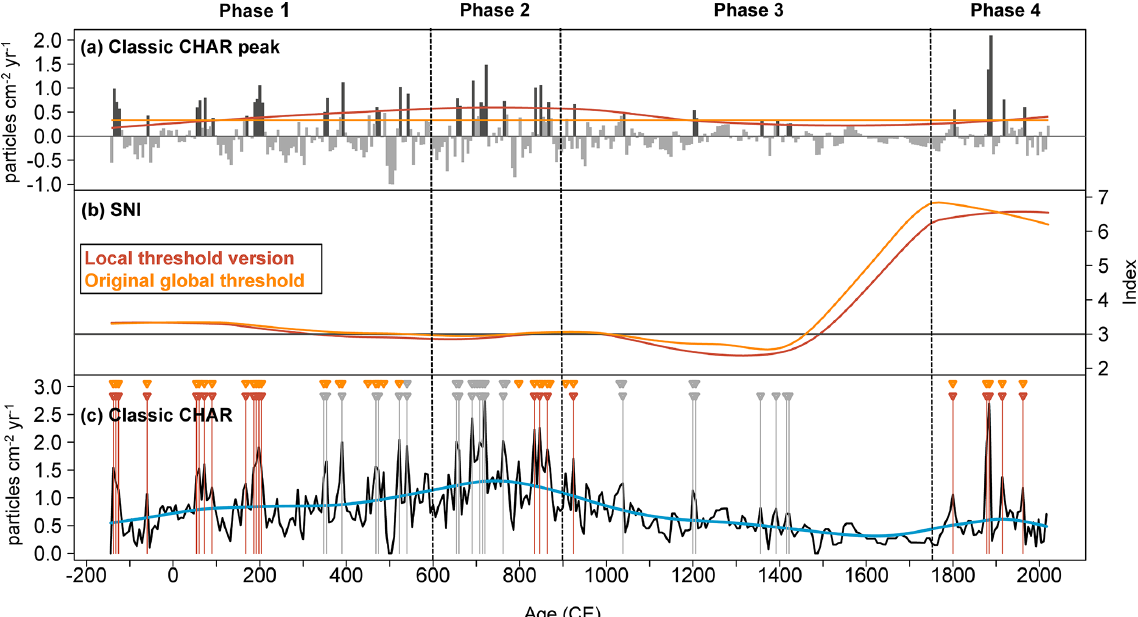
Figure A1. Classic CHAR comparing the alternative local threshold (red) to the global threshold (orange). Vertical dashed lines mark the different phases of the fire regime. (a) Classic CHAR peak component (dark-grey bars = signal; light-grey bars = noise; coloured lines = threshold versions). (b) SNI based on Kelly et al. (2011) (black horizontal line = SNI cut-off value of 3). (c) Classic CHAR sum (black line = interpolated CHAR; blue line = LOESS representing the CHAR background component; red and orange marks = fire episodes for local and global threshold versions, respectively; with colour = fire episodes with SNI > 3; in grey = fire episodes with SNI < 3).